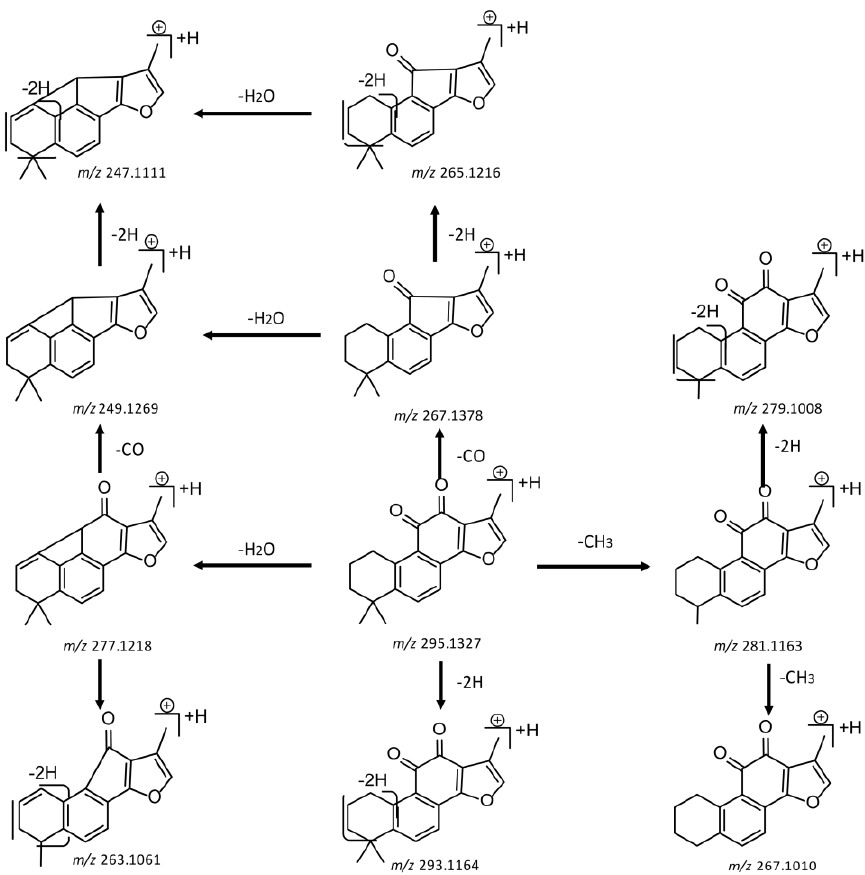
Figure 4. The fragment behaviors of tanshinone IIA in a positive ion mode.